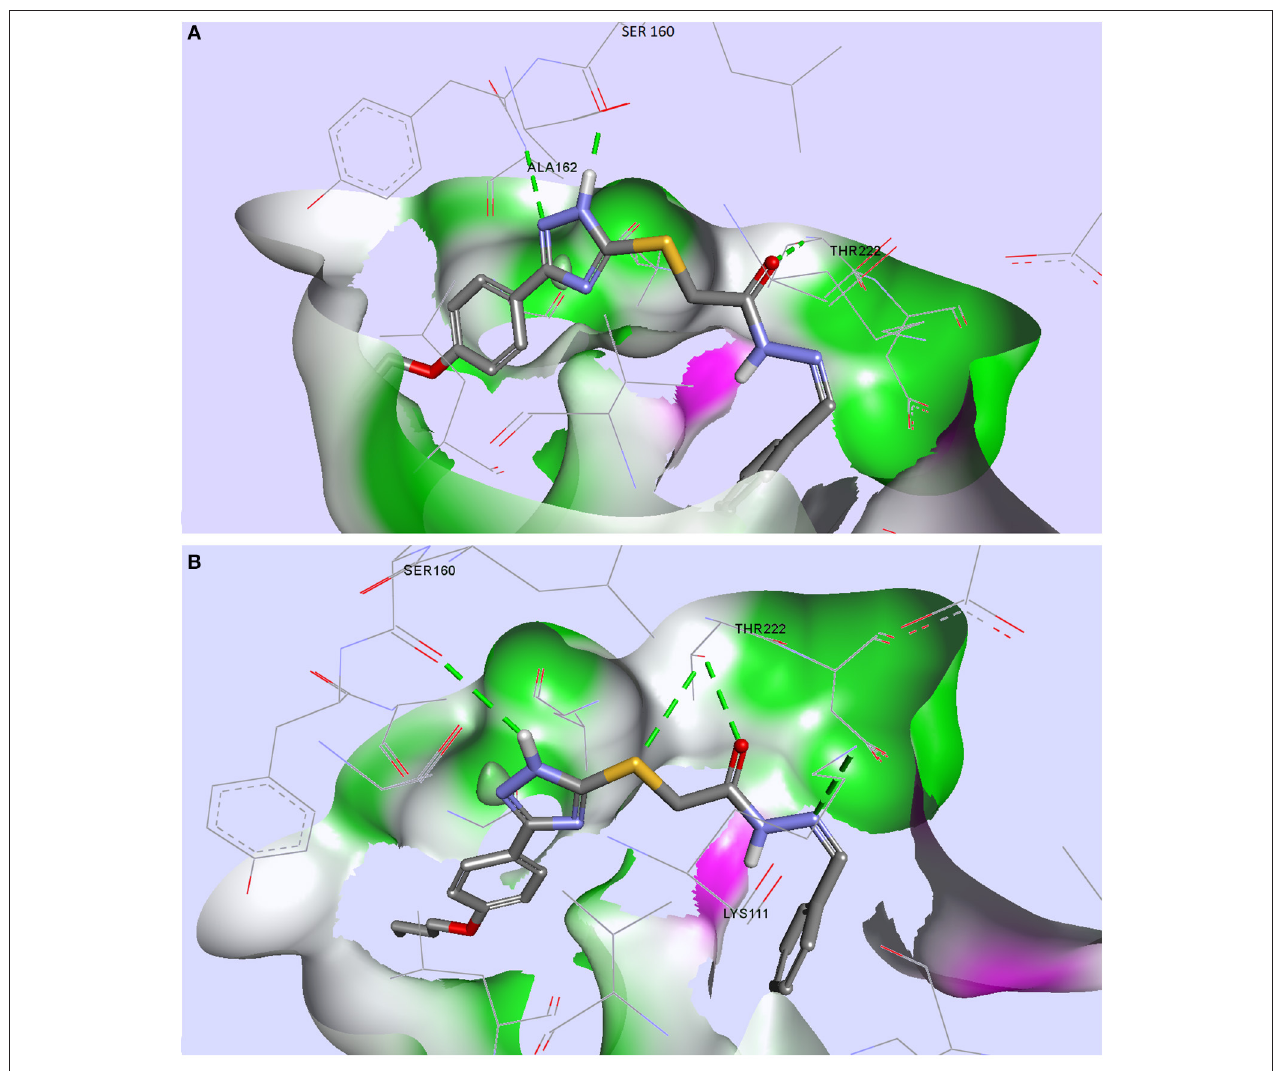
FIGURE 5 | Compounds TZ53.7 (A) and TZ55.7 (B) docked in the active site of PDK1, PDB ID: 2PE1; HBs are depicted as green dotted